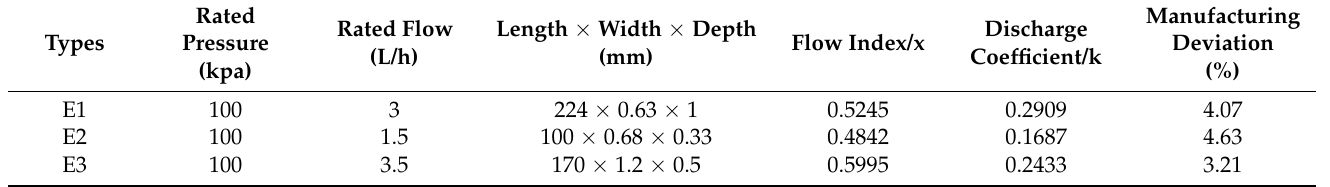
Table 1. Types and fundamental dimensions of the emitters.